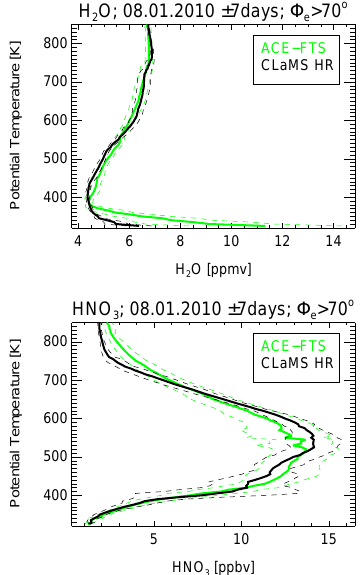
Fig. 4. Comparison of CLaMS H 2 O and HNO 3 mixing ratios (black) with ACE-FTS observations (green). The ACE-FTS data is the average of all available data profiles within the time range of 8 January 2010 ± 7days and with equivalent latitudes greater than 70 ◦ N. The dashed lines correspond to the standard deviation of the modelled and measured data ( ± 1 σ , black and green,